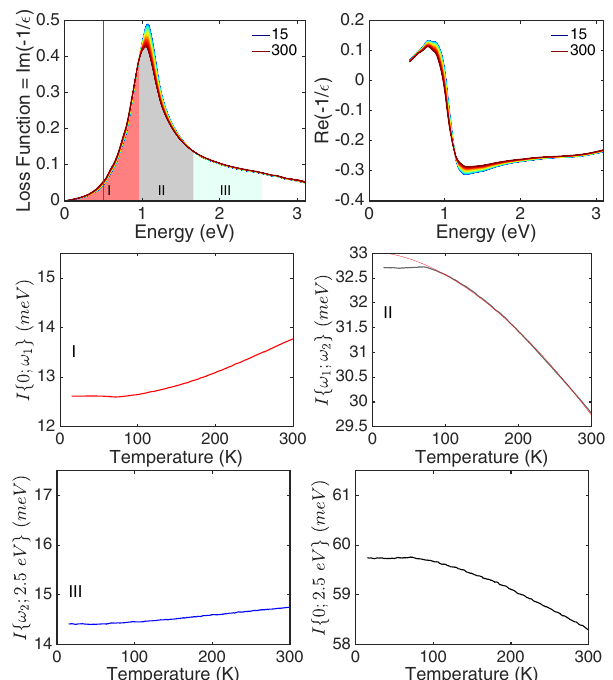
c − 200 K and 200 – 300 K FIG. 14. Sample Bi2212-70-OD. Caption details as in Fig. 8. c The value of the fitted exponent α is